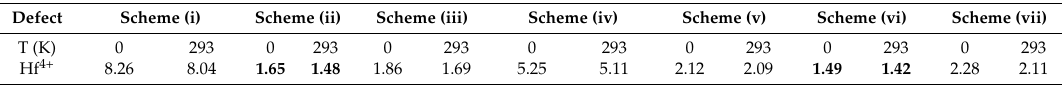
Table 7. Solution energies, in eV, for the bound defect (per dopant